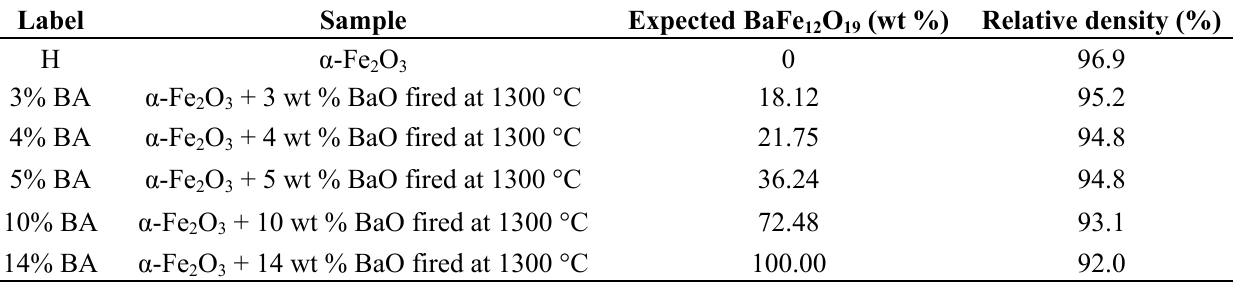
Table 1. Density of the barium-doped hematite pellets with polyethylene glycol (PEG) addition.